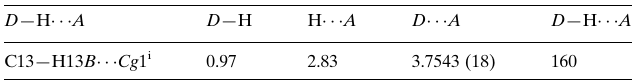
Hydrogen-bond geometry (A˚ , (cid:2)